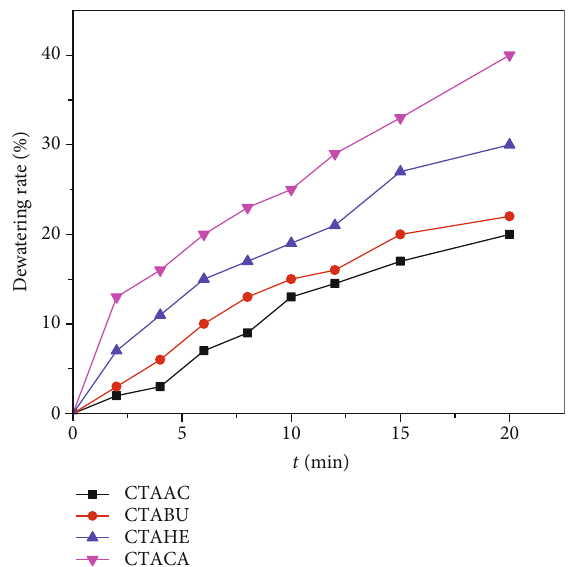
Figure 9: Dewatering rate of four emulsions with the same